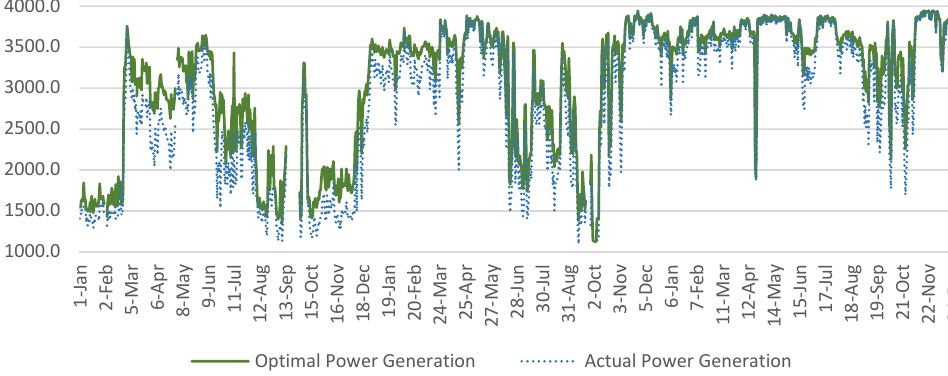
Figure 5. Optimal and power generation chart for 2016–2018.